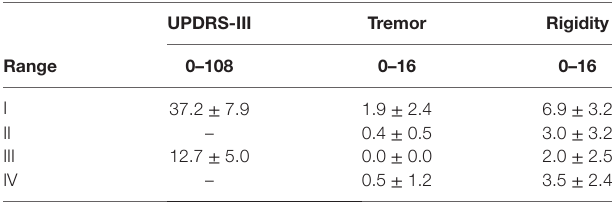
Table 2 | UPDRS-III score and limb rest tremor and rigidity during the measurement phases